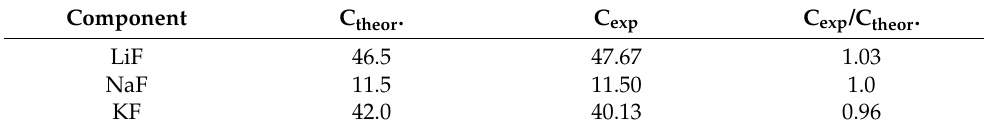
Table 1. Theoretical and experimental content (mol.%) of LiF, NaF and KF in prepared eutectic FLiNaK.